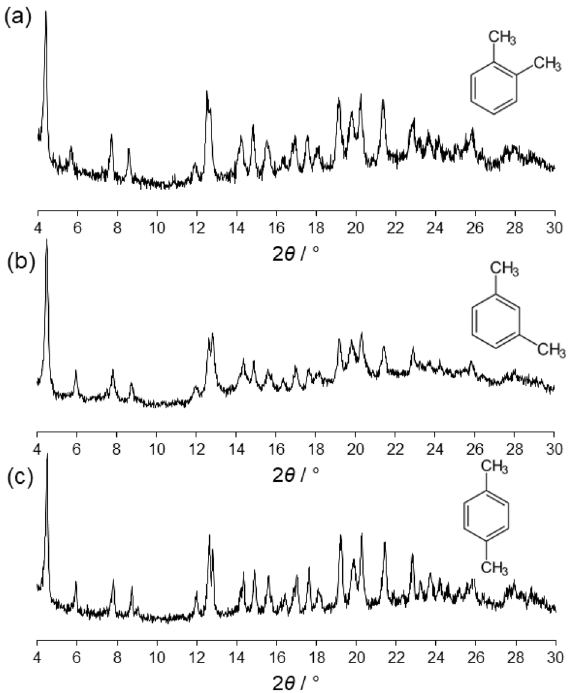
Figure 9. Experimental powder XRD patterns measured at room temperature of a1 ′ exposed to o -xylene ( a ), a1 ′ exposed to m -xylene ( b ) and a1 ′ exposed to p